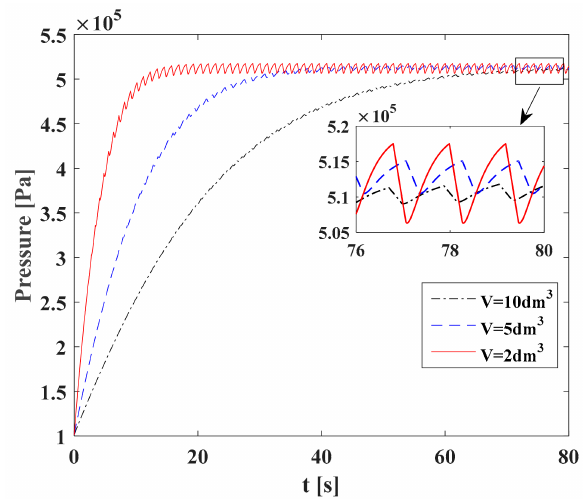
Figure 13. Pressure fluctuations in the